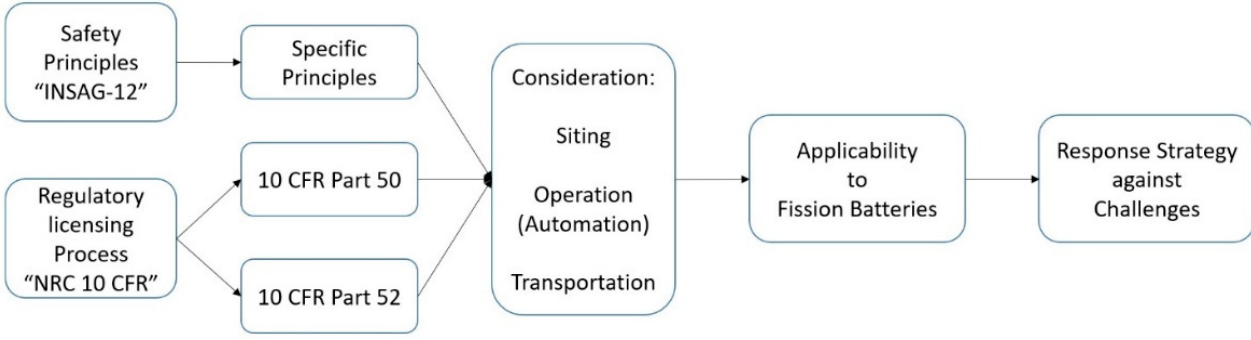
Figure 1. Regulatory review process in this